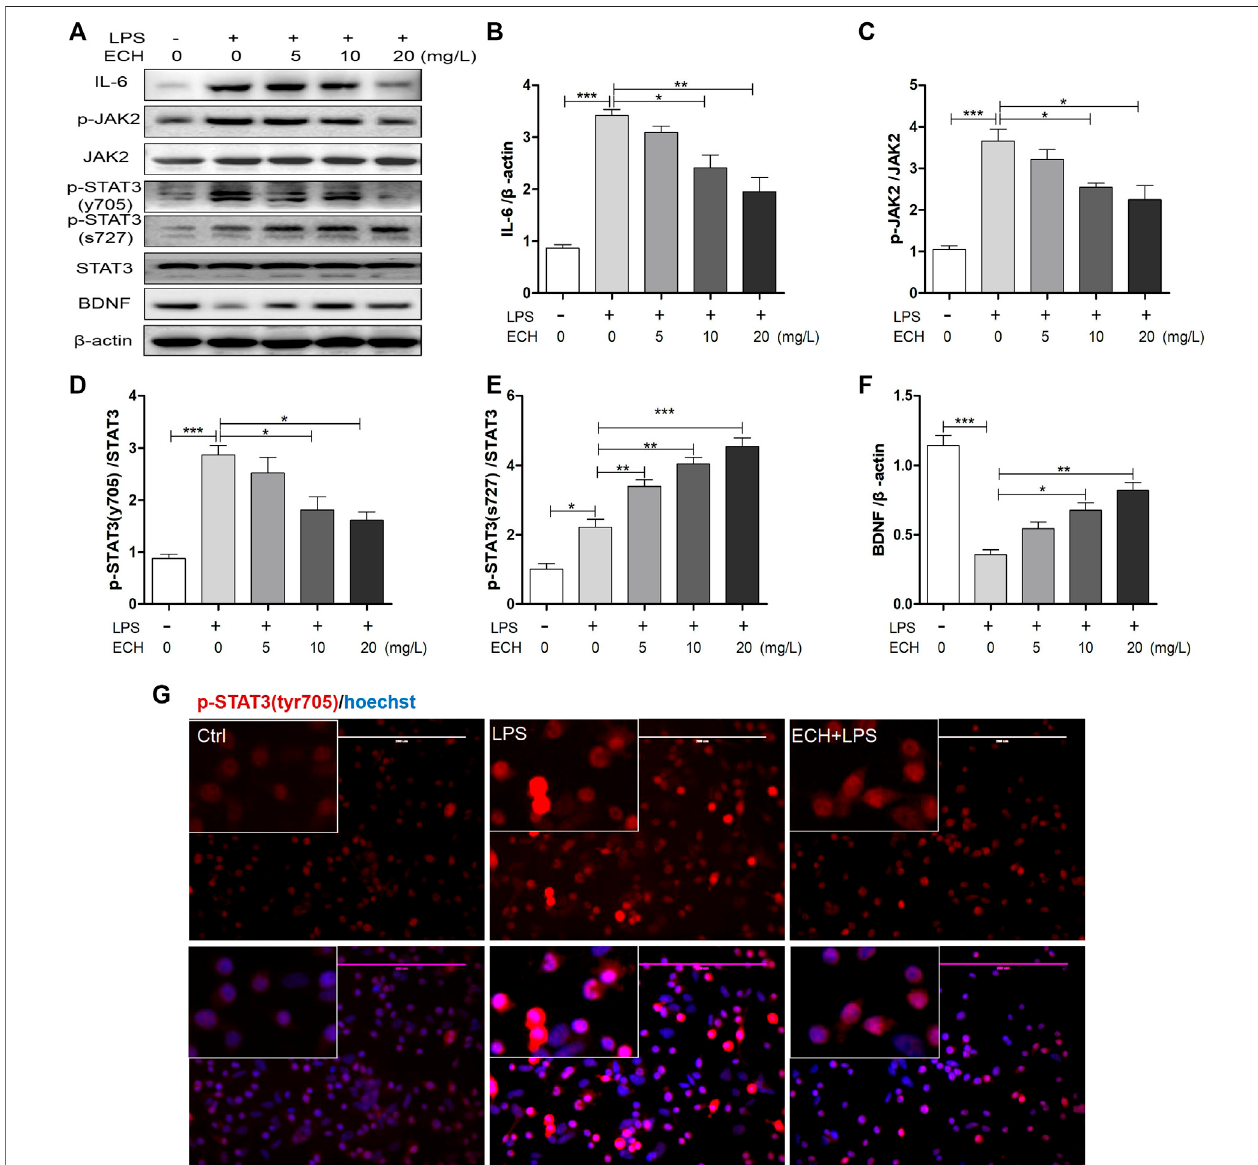
FIGURE 6 | ECH regulated IL-6/JAK2/STAT3 signaling in LPS-induced BV2 cells. (A) BV2 microglial cells were pretreated with ECH (5, 10, and 20 mg/L) for 2 h and exposed to LPS (1 μ g/ml) for 6h; then, the expression levels of IL-6, p-JAK2, JAK2, p-STAT3 (tyr705), p-STAT3 (ser727), STAT3, and BDNF were measured with Western blot. (B) Western blot analysis for IL-6. (C) Western blot analysis for p-JAK2/JAK. (D) Western blot analysis for p-STAT3/STAT3. (E) Western blot analysis for p-STAT3 (ser727)/STAT3. (F) Western blot analysis for BDNF. (G) Immuno fl uorescence staining for p-STAT3 (tyr705) (red) in ECH (20 mg/L, 2 h) pretreated BV2 cells and then exposed to LPS (1 μ g/ml) for 6 h. (H) BV2 cells were pretreated with S3I-201 (STAT3 inhibitor, 100 µM) for 24 h and then treated with ECH (20 mg/L) for 2 h and induced by LPS (1 μ g/ml) for 6 h. The expression levels of IL-6, p-JAK2, JAK2, p-STAT3 (tyr705), p-STAT3 (ser727), STAT3, and BDNF are shown under S3I- 201 treatment. (I) Western blot analysis for IL-6. (J) Western blot analysis for p-JAK2/JAK. (K) Western blot analysis for p-STAT3 (tyr705)/STAT3. (L) Western blot analysis for p-STAT3 (ser727)/STAT3. (M) Western blot analysis for BDNF. Values are presented as the mean ± SEM. * p < 0.05, ** p < 0.01, *** p <